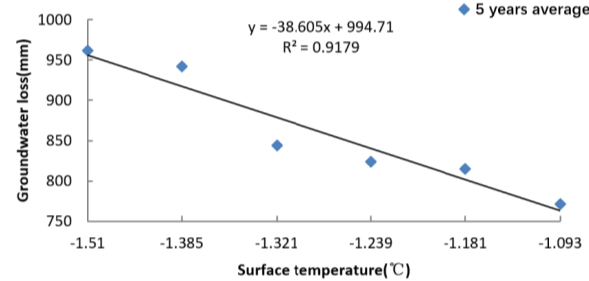
Figure 6. Comparison of the 5-year average of surface temperature and groundwater loss from 1980– Figure 2009.